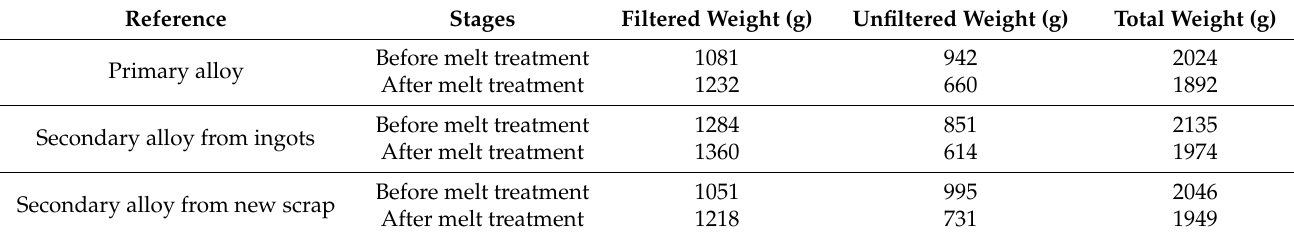
Table 4. The filtered and unfiltered melts during the different trials.